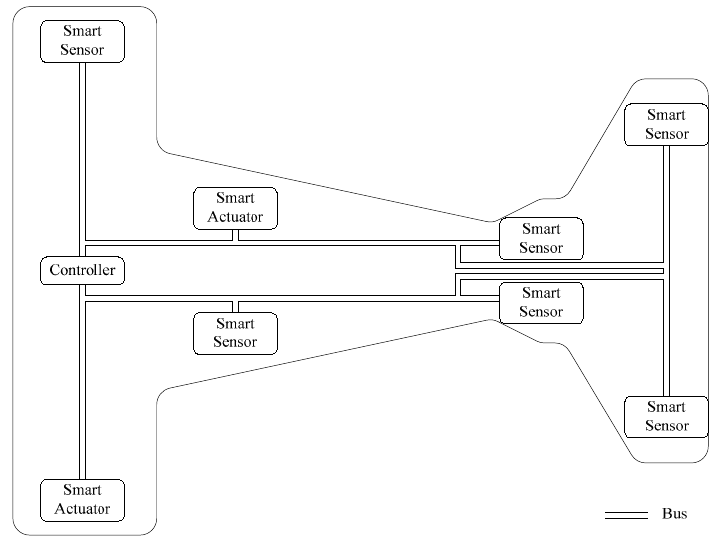
Figure 2. Overview of a traditional aero-engine DCS.